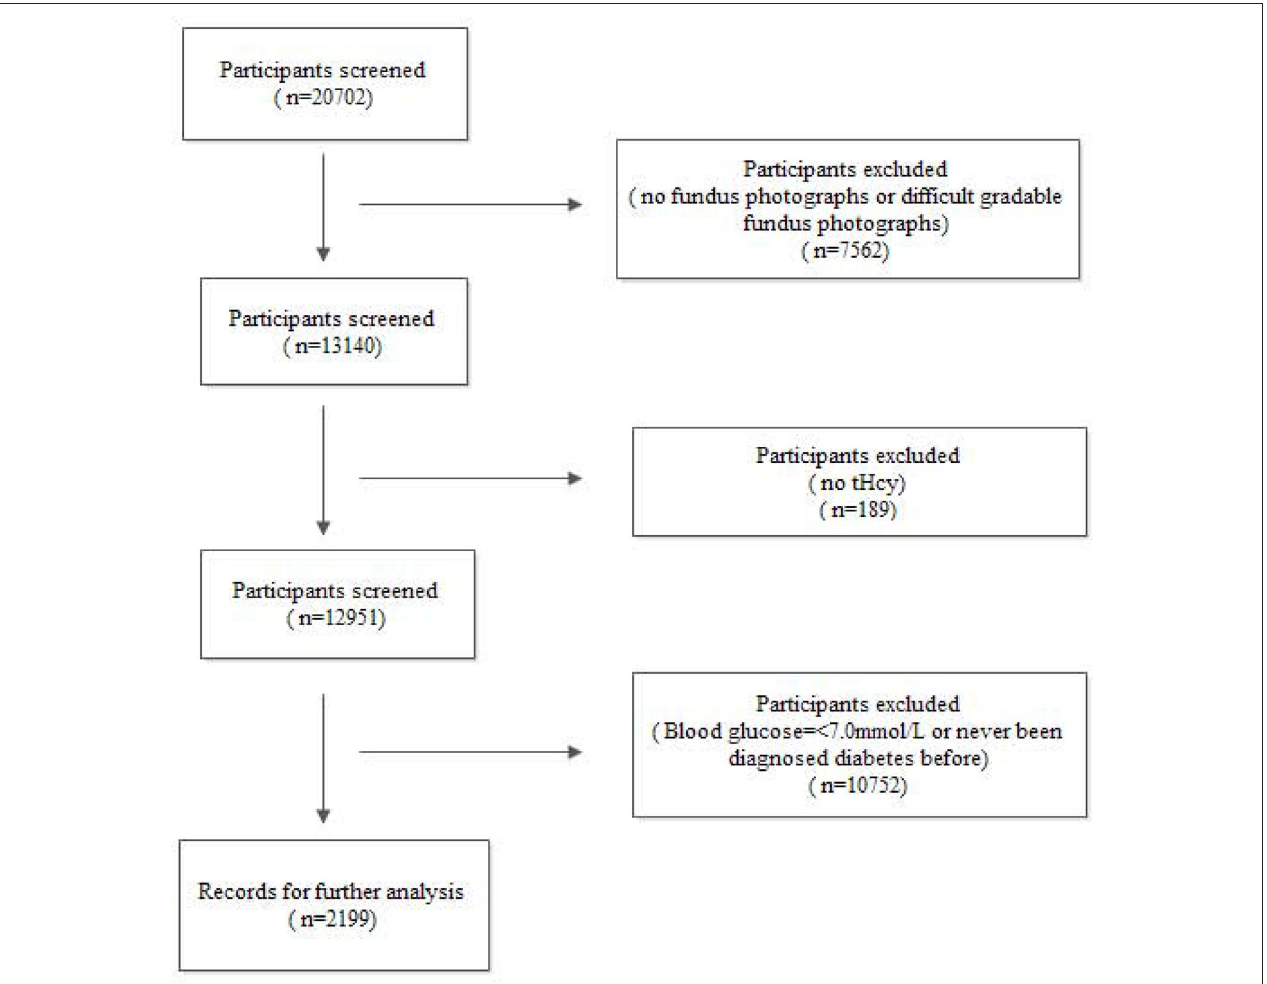
FIGURE 1 | Flow diagram of the screening and enrollment of study participants.